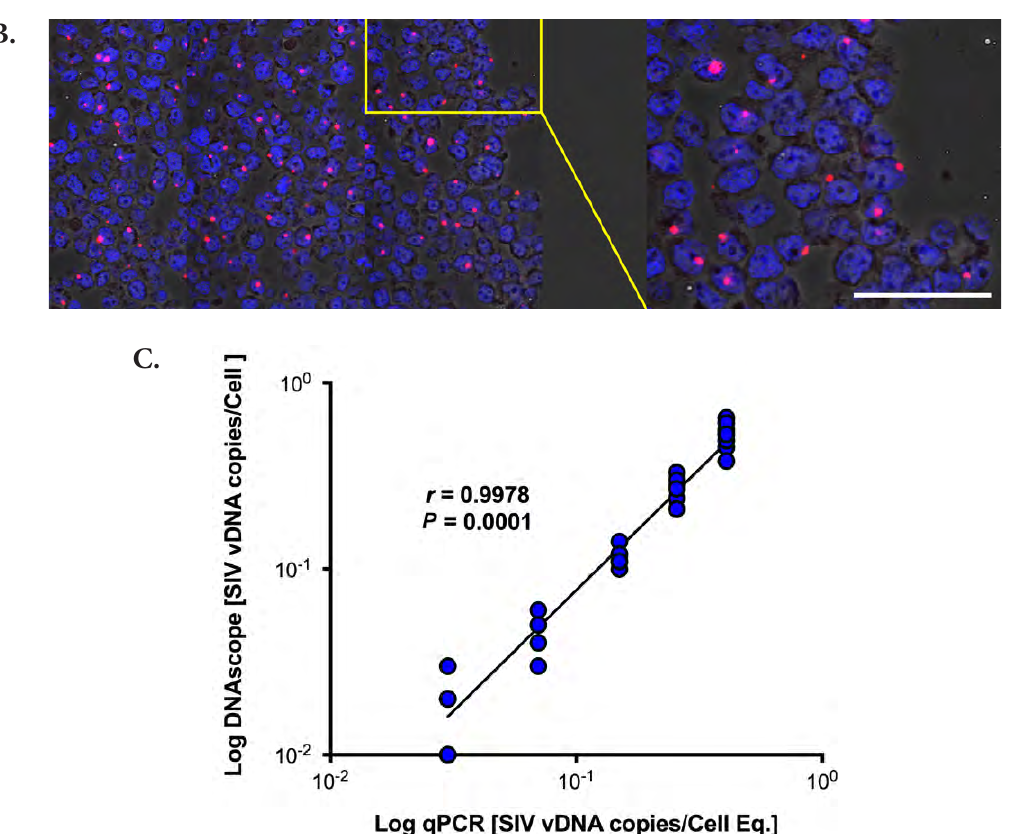
Figure 4. Viral DNA detection in 3D8 cells. (A) Brightfield (scale bar = 20 µm) and (B) confocal (scale bar = 50 µm) 3D8 cell analysis demonstrating vDNA detection specifically within the nucleus of cells with primarily 1 integrated copy of SIV. (C) There is a strong correlation between the quantification of 3D8 cells diluted into CEM cells determined by DNAscope and qPCR. Each symbol represents an individual high magnification image quantified from a single experiment. One of three experiments shown. Data were log10 transformed and P values were based on associations between paired comparisons using the Pear- son’s Correlation